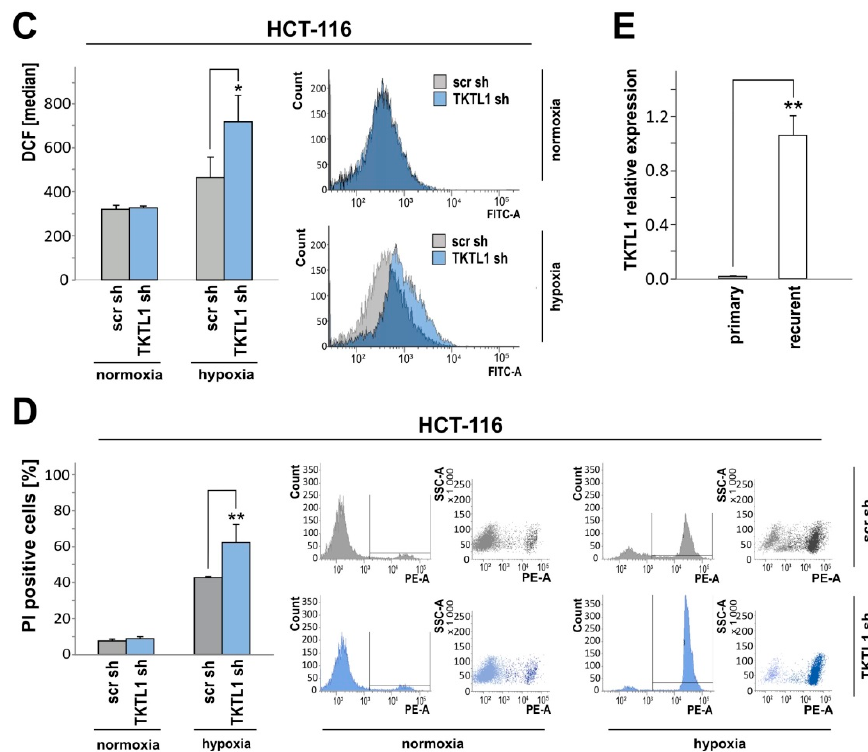
Figure 6. Following TKTL1 knockdown, HCT-116 cells consume more glucose, generate more lactate, and under hypoxic conditions, accumulate more ROS and display less clonogenic survival. ( A ) In HCT-116 cells, shRNA-mediated TKTL1 suppression was verified by RT-qPCR. HCT-116-shTKTL1 and control (scr) cells were exposed to serum-free medium containing 6.5 mM glucose and normoxia or hypoxia. 24 h later, glucose and lactate in supernatants were measured (( B ), mean + SD, * p < 0.05, ** p < 0.01), and intracellular ROS levels were assessed (( C ), median fluorescence intensity, mean + SD, * p < 0.05). After a 30 h incubation in medium supplemented with 2 mM glucose, cell viability was evaluated by PI staining (( D ), mean percentage of PI-positive cells + SD, ** p < 0.01); ( E ) TKTL1 expression in cultured cells from a patient’s primary and recurrent glioblastoma was examined by RT-qPCR (mean + SD of three independent experiments using cells originating from the same surgical specimens, ** p < 0.01).